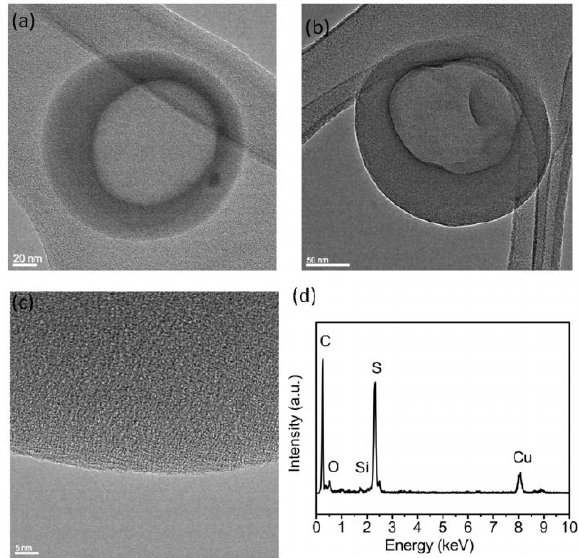
2 3 Figure 12. TEM images of cenospheres with different morphologies collected at 120 m (stage2 Figure 12. TEM images of cenospheres with different morphologies collected at 120 m (stage5 Figure 12. TEM images of cenospheres with different morphologies collected at 120 m (stage8 Fig. 12. TEM images of cenospheres with different morphologies 2). (a) inner hollow structure, (b) another hollow structure, (c) the HRTEM image of part of3 2). (a) inner hollow structure, (b) another hollow structure, (c) the HRTEM image of part of6 2). (a) inner hollow structure, (b) another hollow structure, (c) the HRTEM image of part of9 collected at 120m (stage 2). (a) Inner hollow structure, (b) another (b). (d) EDS collected from the cenosphere in Figure 12b.4 (b). (d) EDS collected from the cenosphere in Figure 12b.7 (b). (d) EDS collected from the cenosphere in Figure 12b.10 hollow structure, (c) the HRTEM image of part of (b) . (d) EDS collected from the cenosphere in Fig.